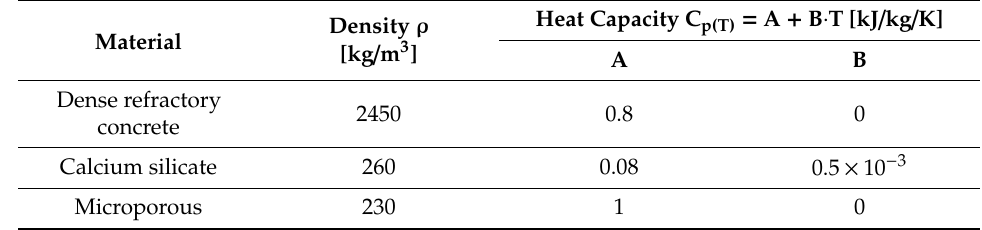
Table 9. Density and heat capacity of solid particles in the